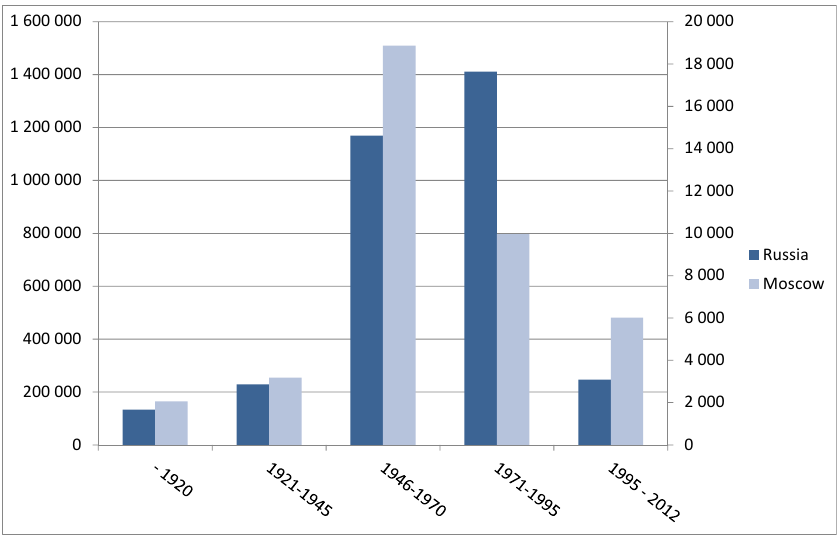
Figure 2. Number of apartment buildings by the year of construction in Russia and in Moscow (Source: [30]).